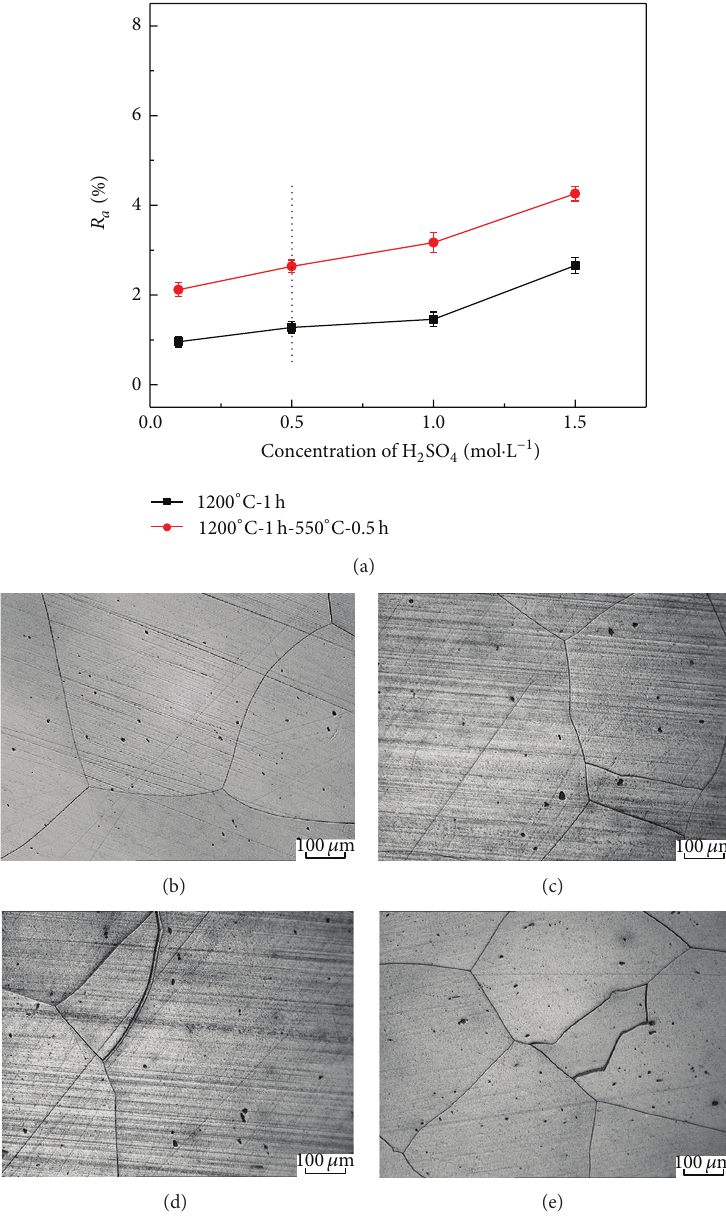
Figure 1: Effect of H 2 SO 4 concentration in the DL-EPR test. (a) Influence on 𝑅 𝑎 values ( 𝑑𝐸/𝑑𝑡 = 100 mV/min and 𝑇 = 30 ∘ C); (b)–(e) micrographs of FSS 429 aging at 550 ∘ C for 1h after test, (b) 0.1M H 2 SO 4 , (c) 0.5 M H 2 SO 4 , (d) 1.0M H 2 SO 4 , and (e) 1.5M H 2 SO 4